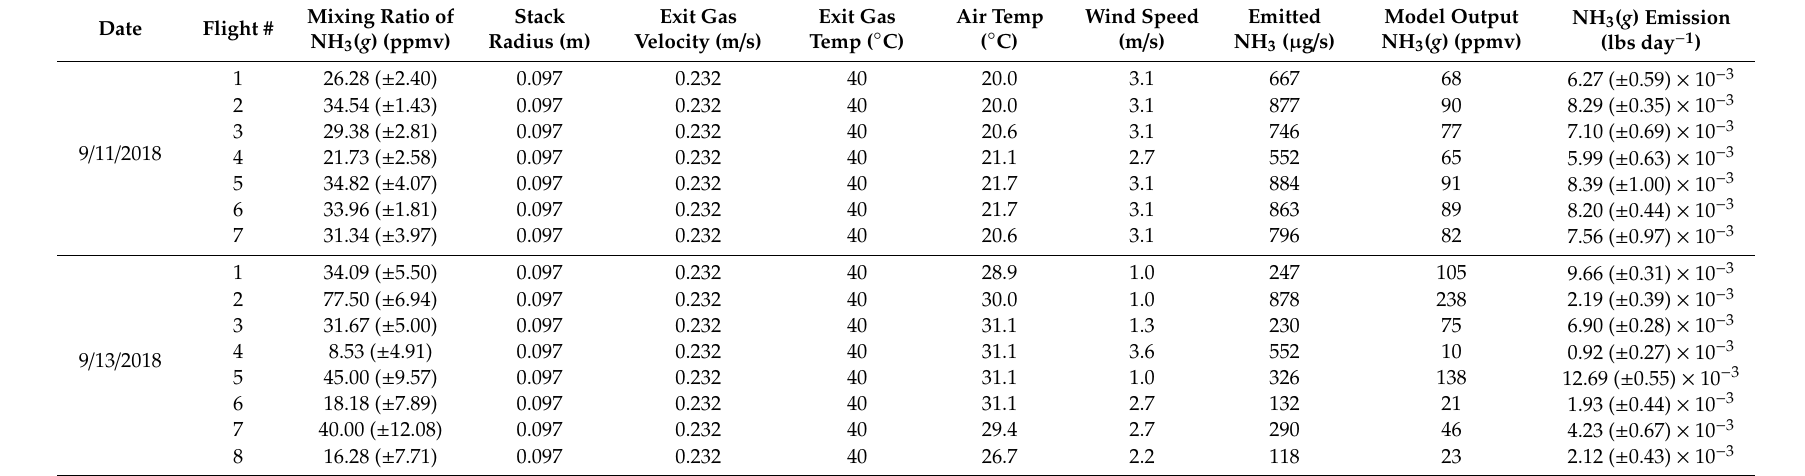
Table 1. Input parameters for the Gaussian plume modeling and